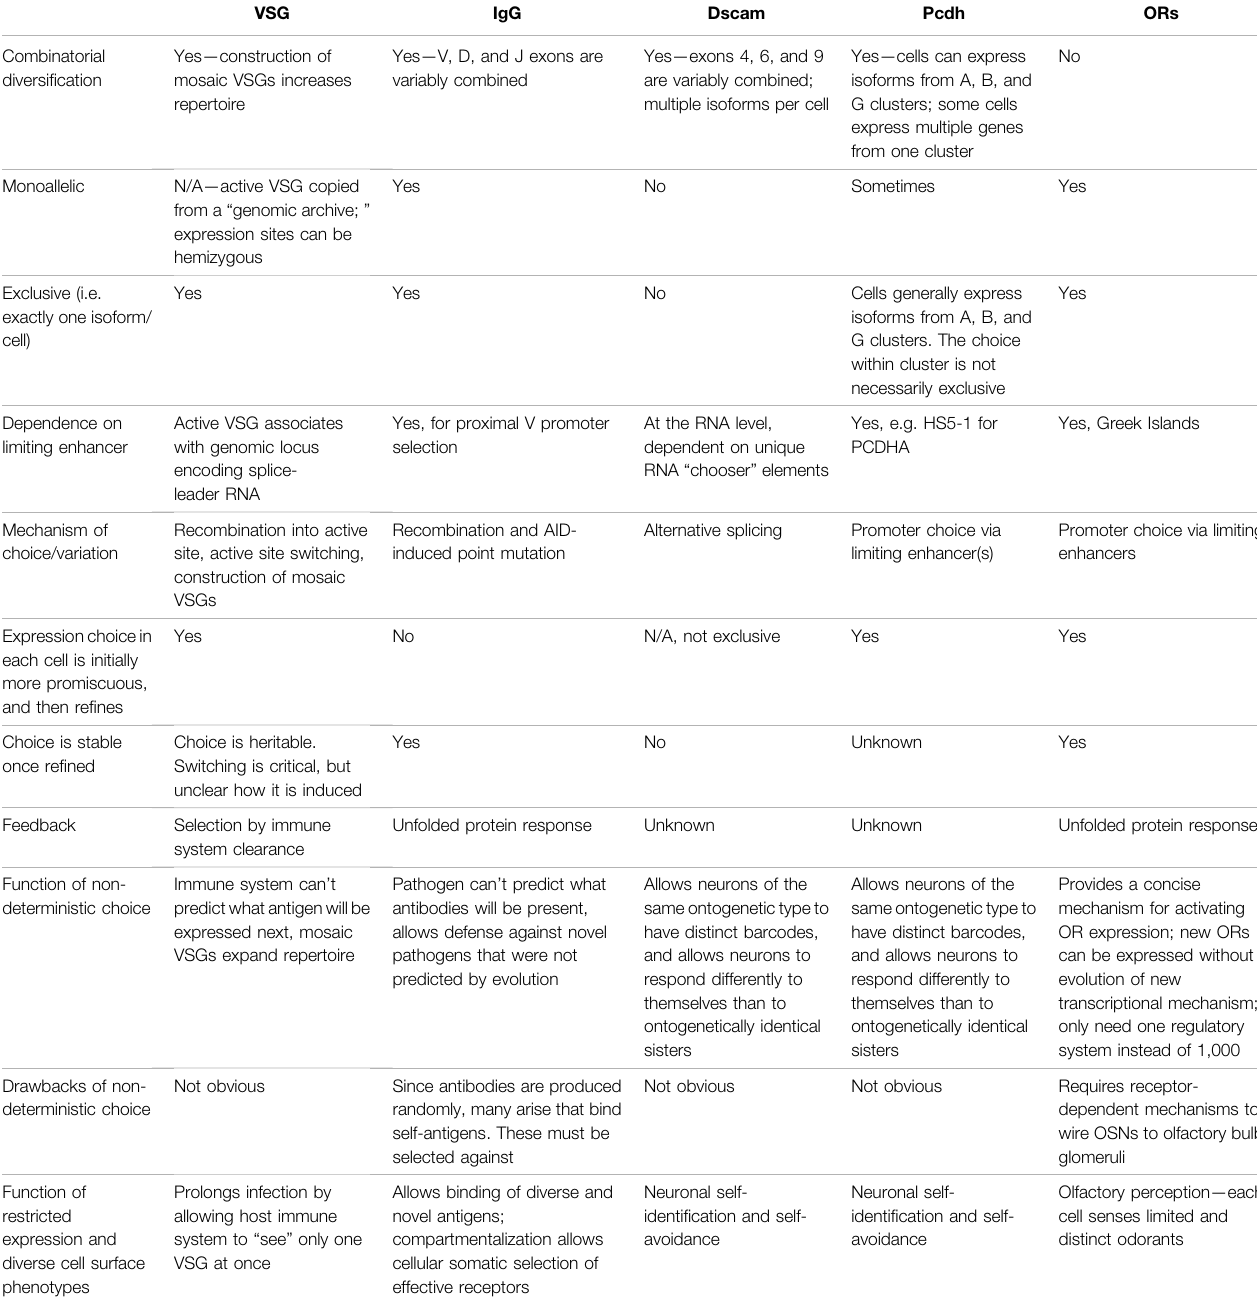
TABLE1| Comparisonofnon-deterministicsystemsofcellsurfacemoleculeexpression.Forbrevity,referencesarenotincluded;theyareprovidedthroughoutthemaintext description of each